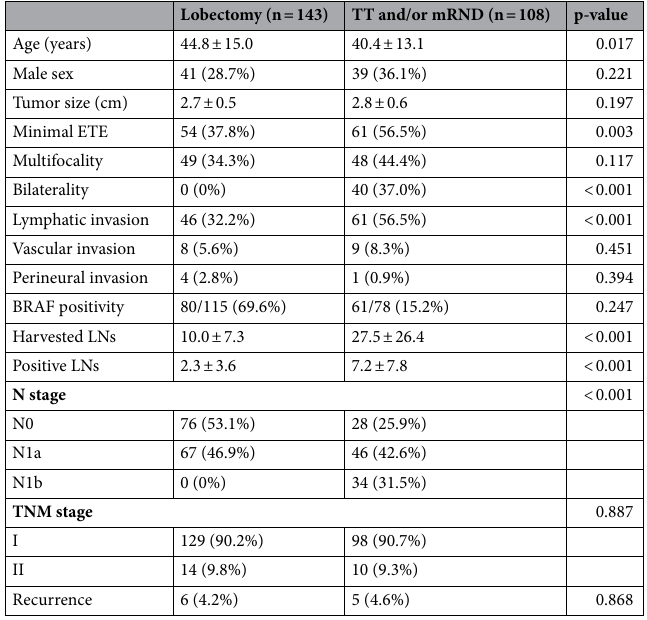
Table 1. Baseline clinicopathological characteristics according to the extent of surgery. Data were expressed as number (%) or mean ± standard deviation. A statistically significant difference was defined as p < 0.05. TT total thyroidectomy, mRND modified radical neck dissection, ETE extrathyroidal extension, LN lymph node, T tumor, N